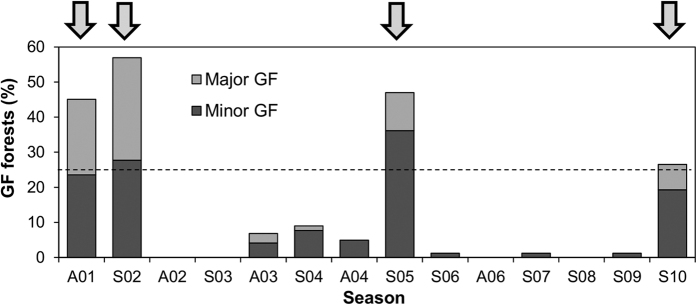
Percentage of GF forests in 14 observations (refer to Table S1 for GF codes).The dashed line at 25% fruiting magnitude is a threshold indicating large-scale GF events (arrows).